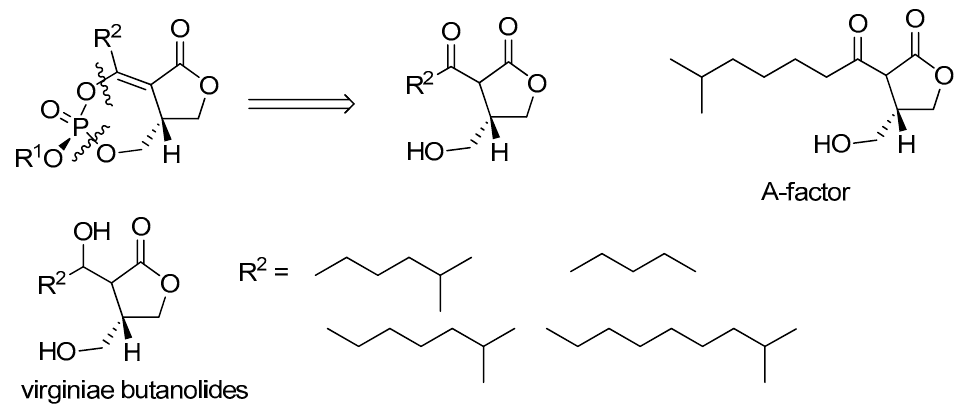
Figure 4. A-factor and virginiae butanolides.